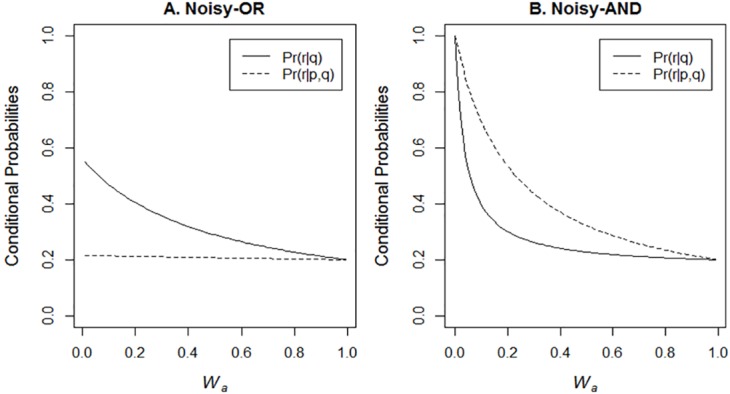
Discounting with the noisy-OR (A) and augmentation with the noisy-AND (B) integration functions varying the probability of alternative causes Wa.For noisy-OR, unless Wa = 1, Pr(r|p, q) < Pr(r|q) and discounting is predicted. For noisy-AND, unless Wa = 1 or 0, Pr(r|p, q) > Pr(r|q) and augmentation is predicted. In these graphs Pr(p) = Pr(r) = .2 and Wp = Wr = Wpr = .9.